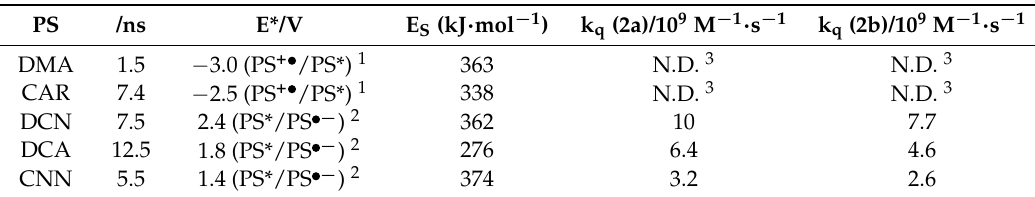
Table 1. Photophysical properties of the selected photosensitizers and their quenching rate constants by 2a and 2b